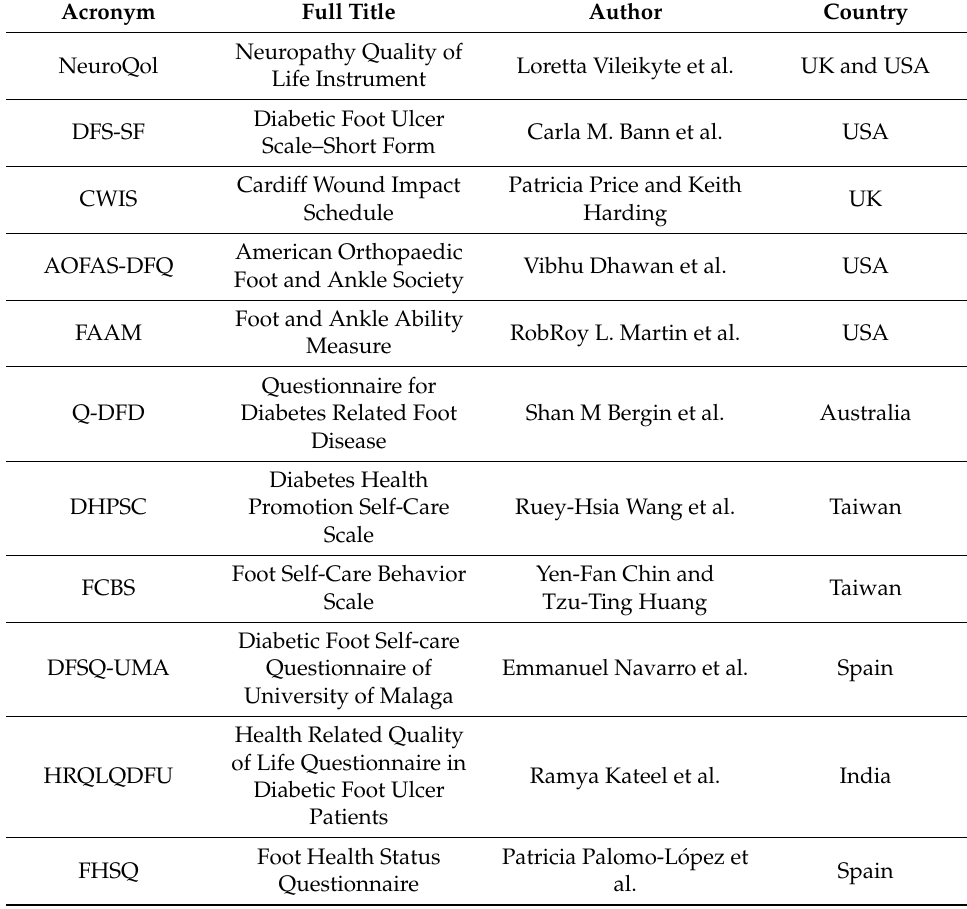
Table 1. Instrument included.